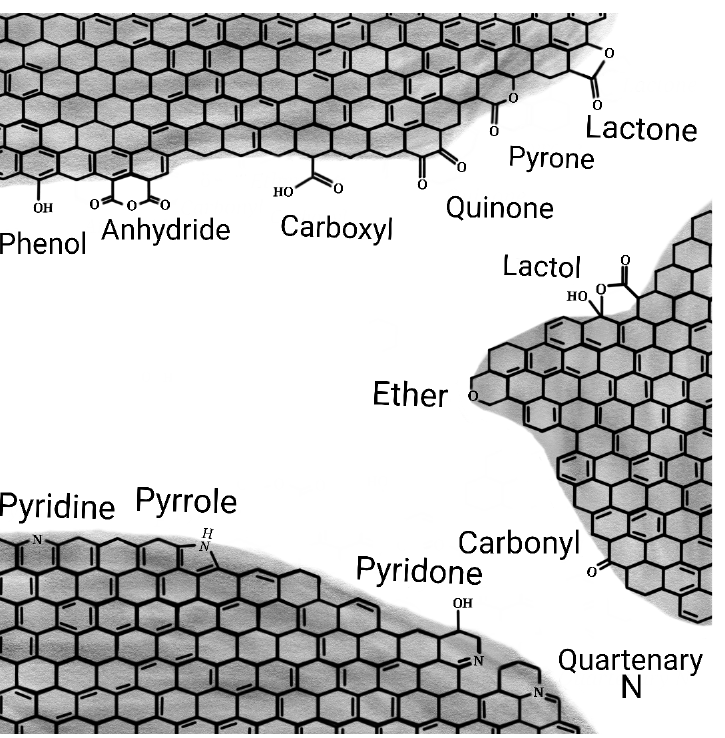
Figure 8. An illustration of functional groups on the carbon surface.